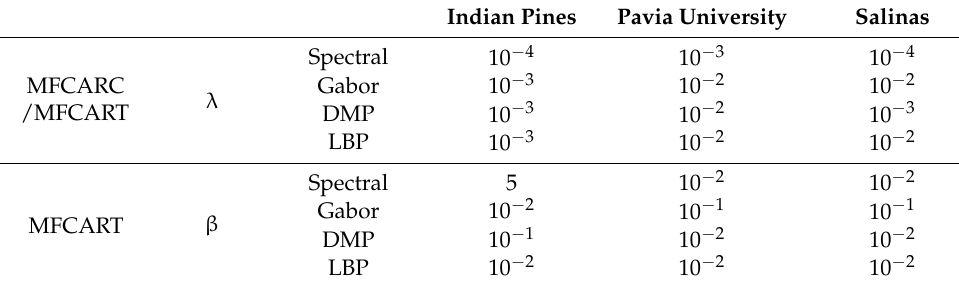
Figure 6. Classification accuracy versus varying β for the proposed MFCART method. ( a ) Indian Pines. ( b ) Pavia University. ( c ) Salinas. Table 5. Optimal parameters for the proposed methods.